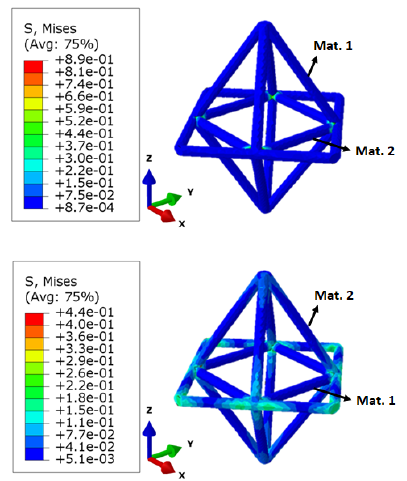
Figure 4. Von Mises stresses of a two-phase system caused by temperature